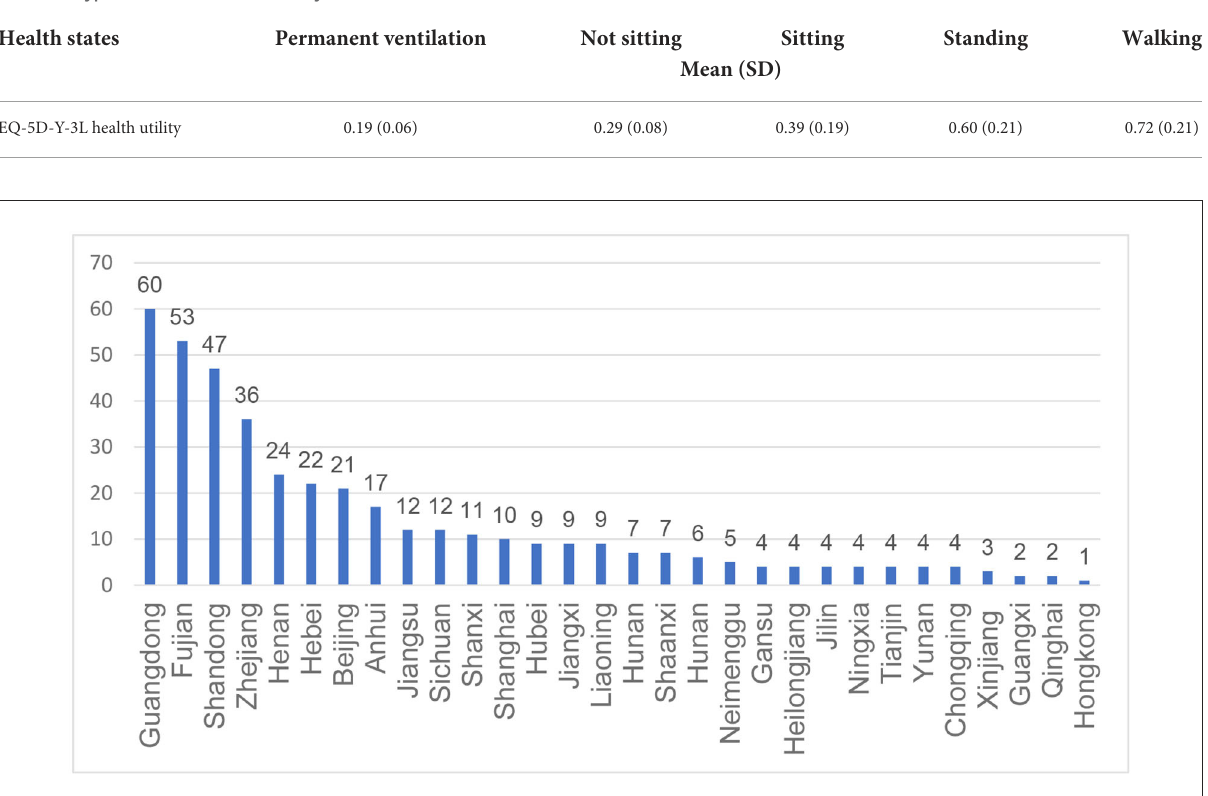
TABLE 1 Type I SMA health states utility values.